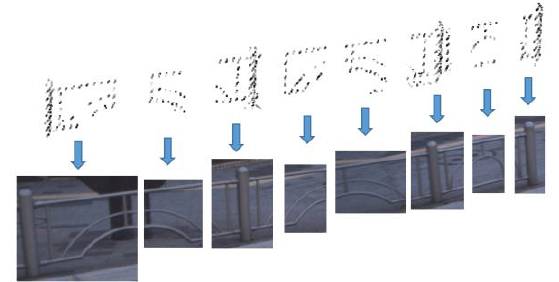
Figure 8. Cropped images of sliced segments